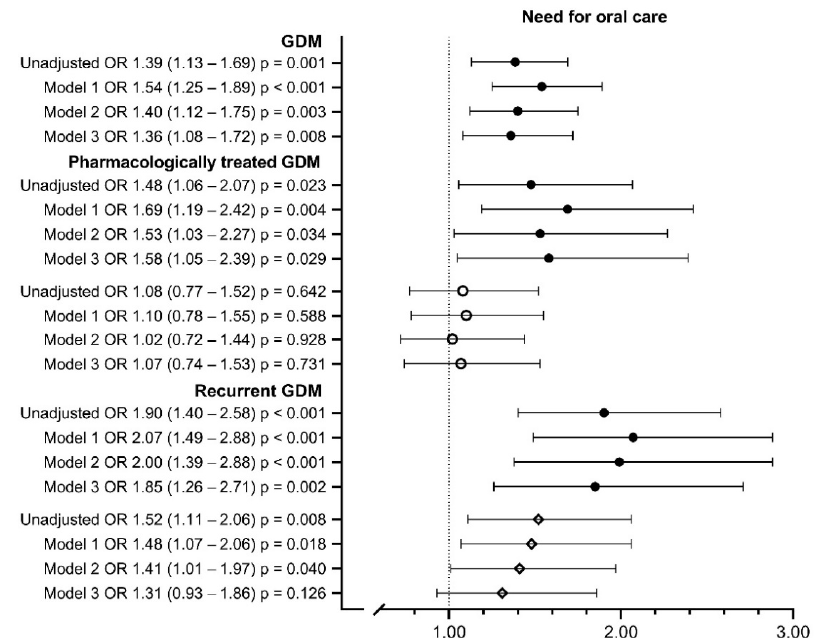
Figure 2. Need for oral care in women with gestational diabetes and its subgroups compared to their controls. Model 1 includes maternal age at delivery and parity; Model 2 includes Model 1 + pre-pregnancy BMI; Model 3 includes Model 2 + smoking during pregnancy, educational attainment, asthma and insomnia and/or mental disorders. ● Compared to controls . ◦ Compared to women with diet-treated GDM . ◊ Compared to women with first-onset GDM . Missing values were 0.8–1.0% in Models 1 and 2 and 5.7–7.0% in Model 3. OR, odds ratio; CI, confidence interval. Women with GDM had their third molars removed more often than the controls (OR 1.27; 95% CI 1.05–1.69; 2.0, 1.6 (mean, standard deviation) vs. 1.8, 1.6; p < 0.05) (Table 4, Figure 3), but parity, maternal age (Model 1 OR 0.95; 95% CI 0.78–1.16) and other clinical background risk factors largely explained the difference (Figure 3). Women with pharmacologically treated GDM reported symptoms of the third molar more often than the controls (46.9% vs. 36.1%; OR 1.57; 95% CI 1.15–2.15) or women with diet-treated GDM (38.0%, Model 3 OR 1.50; 95% CI 1.07–2.11) (Table 4, Figure 4).